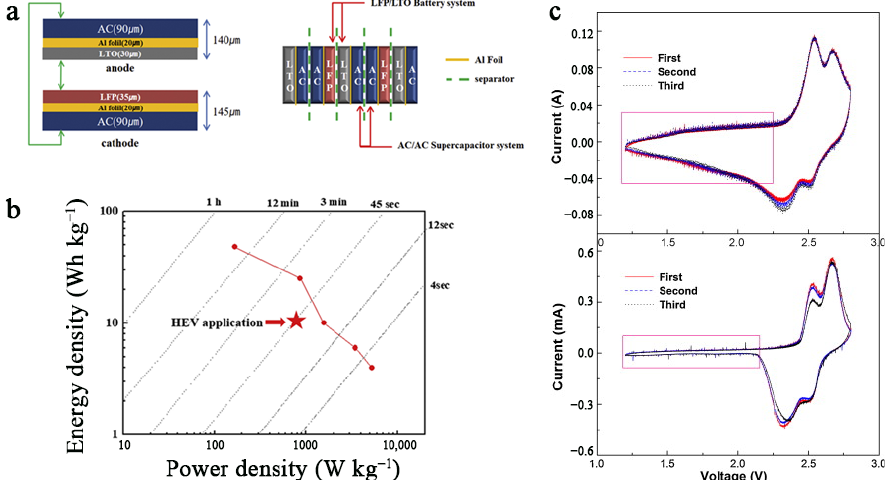
Figure 6. (LFP+AC)//(LTO+AC) LIBCs: ( a ) Schematic diagram of a hybrid device with segmented cathode and segmented anode; ( b ) Ragone plot. The red star represents the requirement of hybrid electric vehicles (HEVs) [53]. ( c ) CV profiles of the (LMO+AC)//LTO LIBC and the LMO//LTO LIB [54].